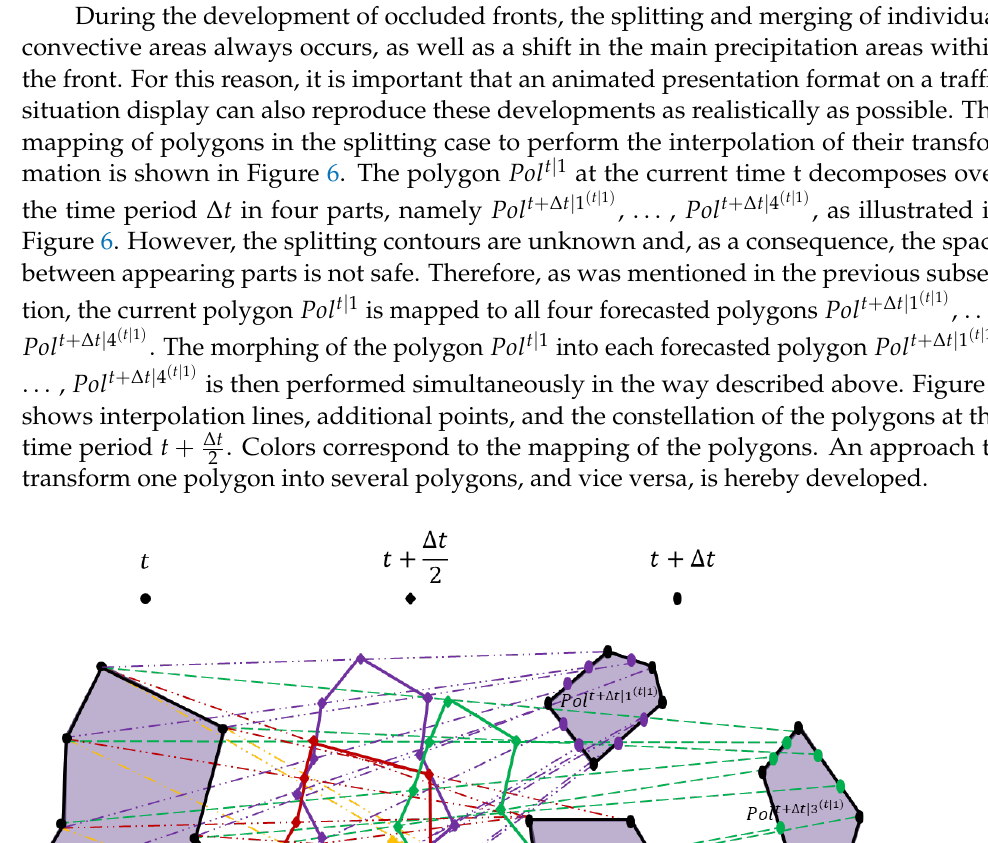
Figure 7. Assignment of polygons for interpolation in the case of simultaneous splitting and merging. Consequently, the presented morphing approach is applicable for general interpolation of the transformation between two sets of closed polygons representing current and forecasted adverse weather areas over a short period of time.